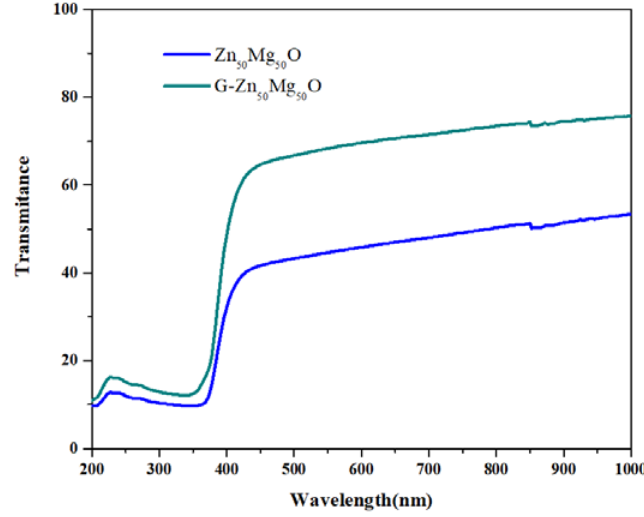
Figure 2. UV-DR spectra of Zn 50 Mg 50 O and G-Zn 50 Mg 50 O.